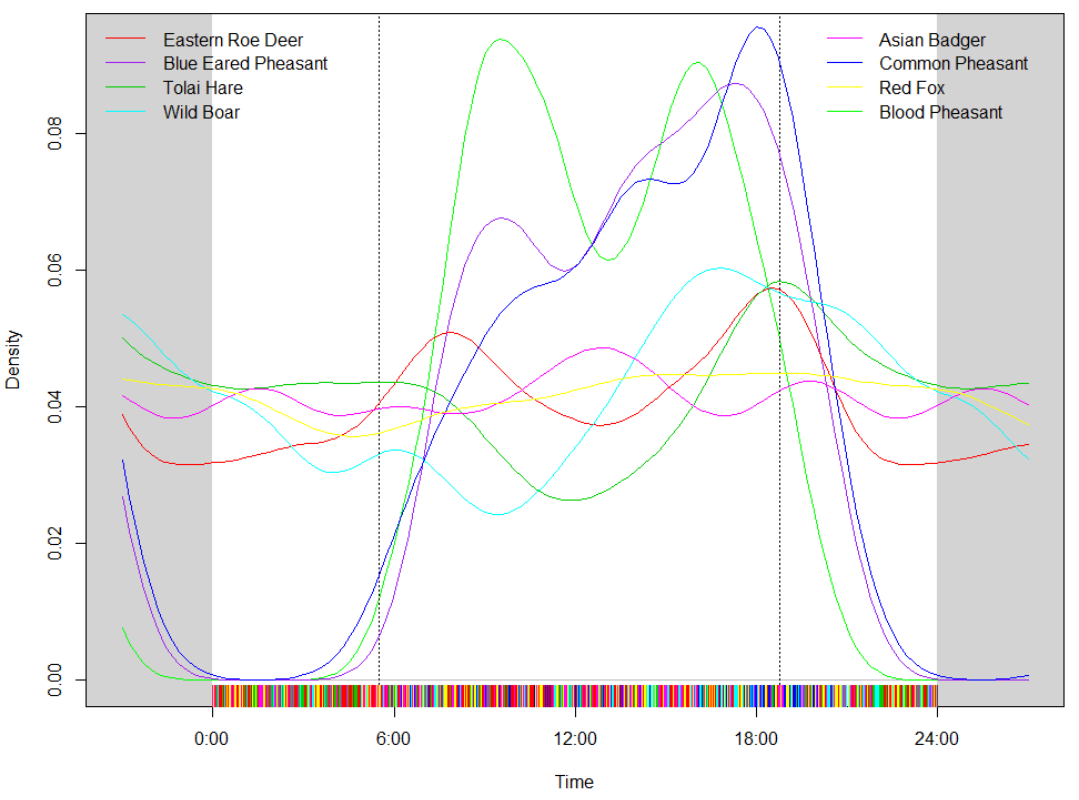
Figure 2. Kernel densities of daily activity of eight animal species (solid line) according to the data from camera traps. Two vertical lines represent the average time of sunrise and sunset, on the eastern Qinghai-Tibet Plateau in 2017 – 2020.